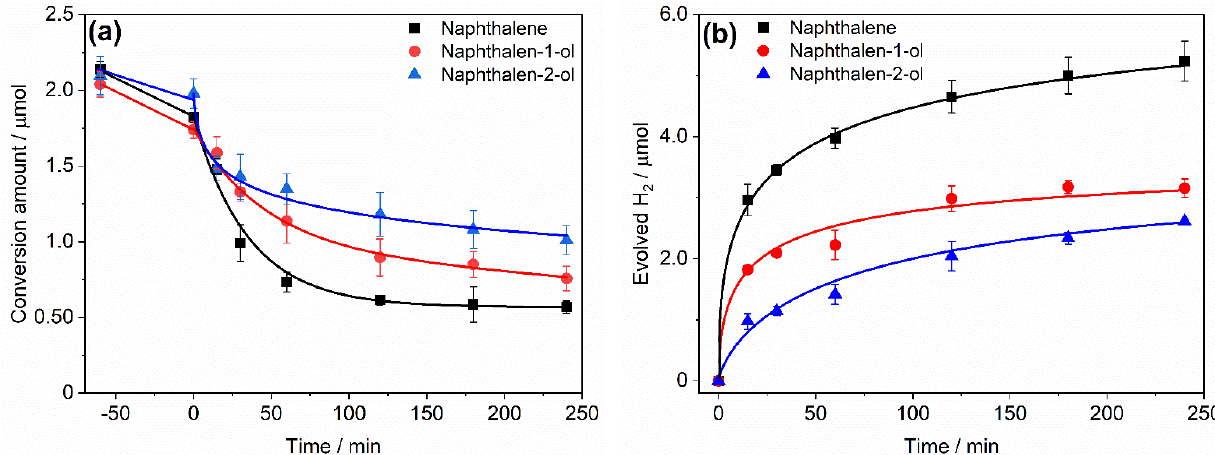
Figure 8. Photooxidation ( a ) and molecular hydrogen formation ( b ) during the photocatalytic reforming of naphthalene, naphthalen ‐ 1 ‐ ol, and naphthalen ‐ 2 ‐ ol as a function of illumination time. Conditions: [Naphthalene] = 2.1 μ mol, [naphthalenols] = 2.1 μ mol, [catalyst] = 1 g L − 1 1.0 wt% Pt ‐ HTiO 2 , T = 25 °C, illumination under simulated solar light.